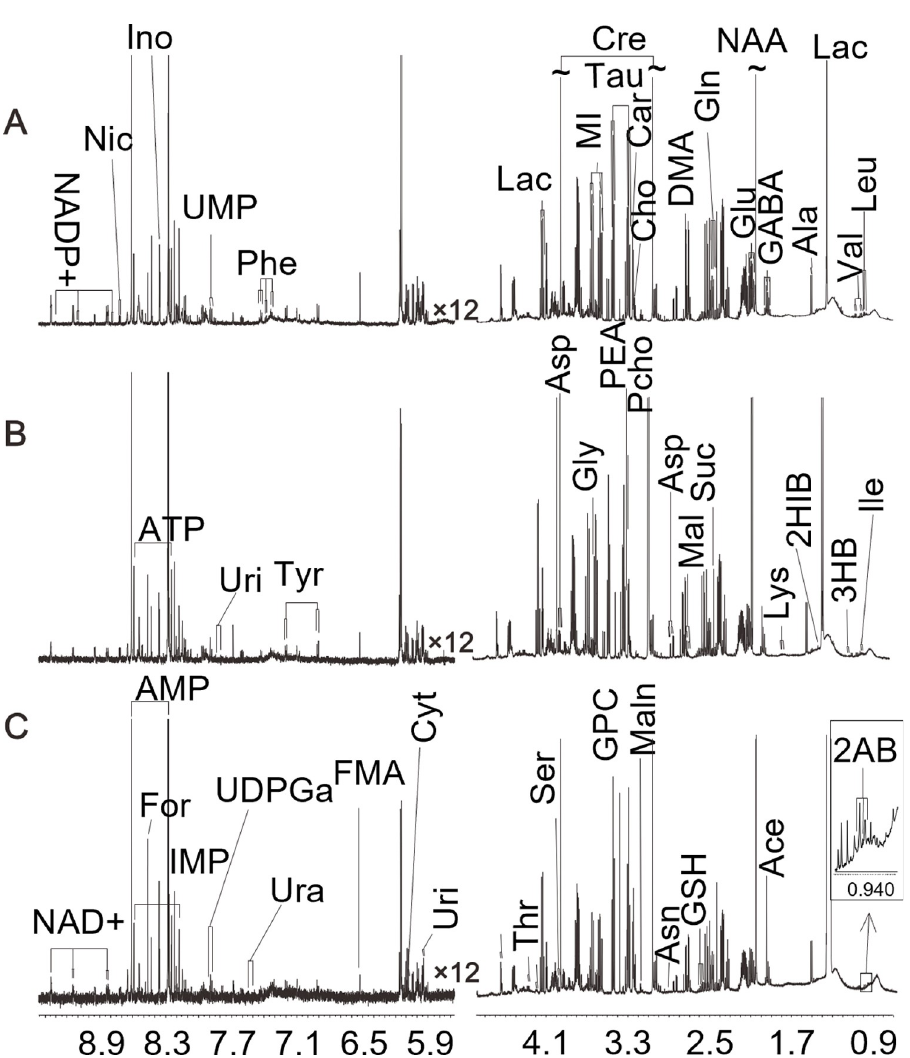
Fig 3. Representative 600 MHz 1H NMR spectra of the cortex (A), hippocampus (B), striatum (C) extracts obtained from the HSD rats, right part of 0.70–4.80 ppm spectral region and left part of 5.65–9.45 ppm spectral region (resonance intensity amplitude enhanced 12-fold of that of right part). The abbreviations of metabolites are shown in Additional file 1: S1 Table.